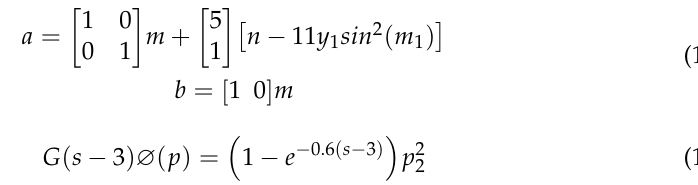
Figure 5. Temperature measured on the road surface.